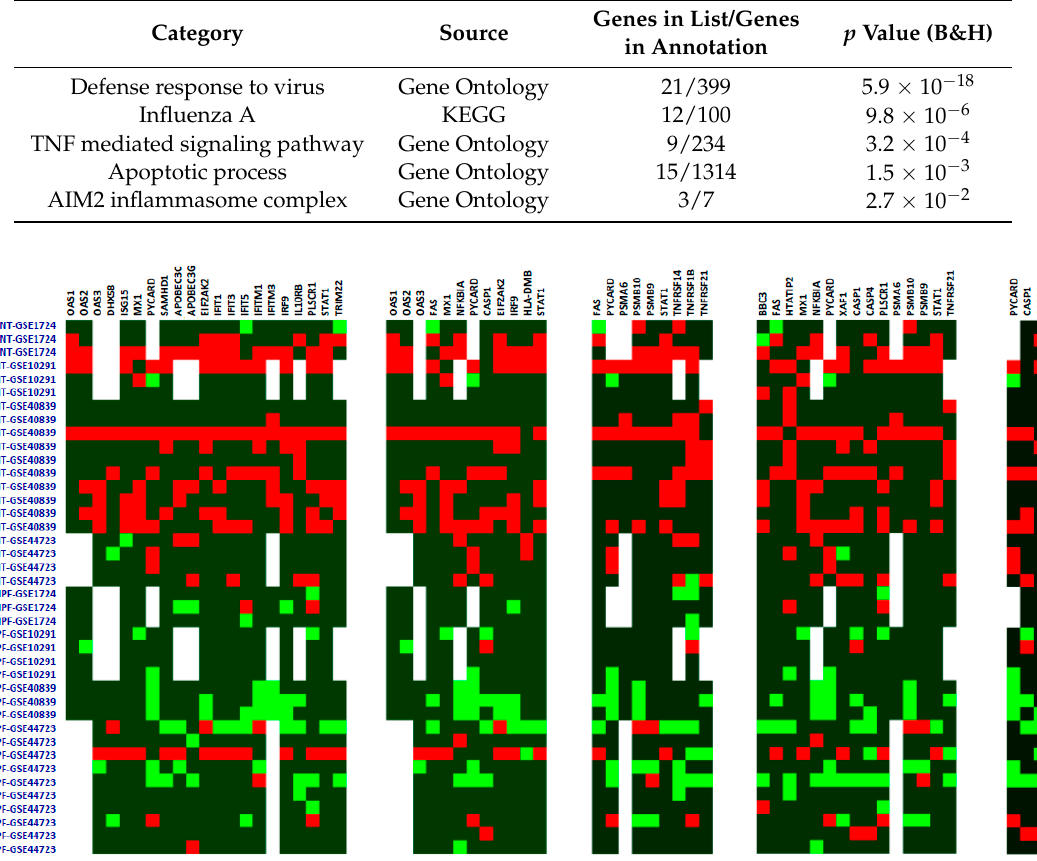
Figure 2. Expression levels of genes belonging to differentially expressed ontology and functional categories. Expression z-scores are shown as a heat map, with red showing increased expression and green showing lower expression. White denotes a missing value. Samples are identified as either Control (CONT) or IPF, followed by their dataset of origin. ( A ) GO-Defense response to virus;